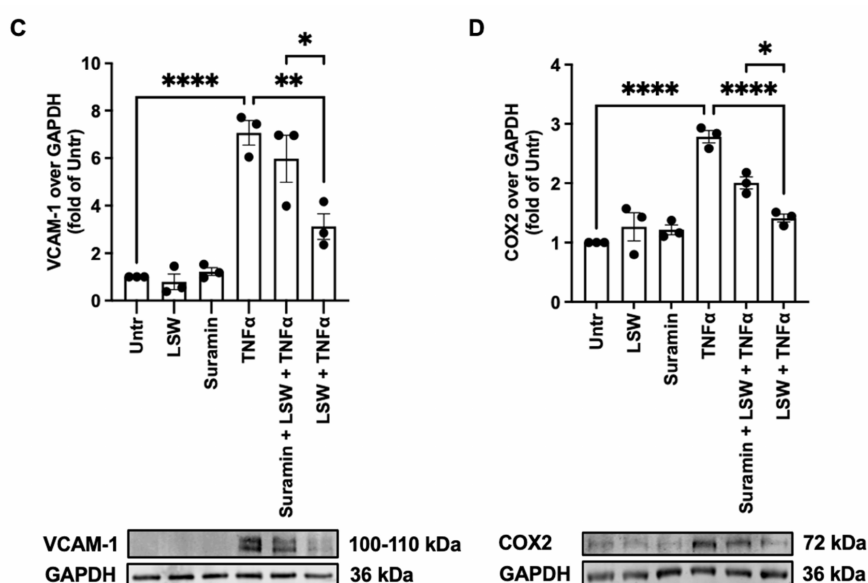
Figure 6. LSW attenuates TNF α -induced inflammation in EA.hy926 cells dependent on SIRT1. Panels ( A , B ) Effect of LSW treatment on SIRT1 expression. The cells were treated with LSW (50 µ M) for 18 h before TNF α (10 ng/mL) stimulation for 6 h, followed by detecting SIRT1 mRNA ( A ) or protein ( B ) expression. Panels ( C , D ) Involvement of SIRT1 in LSW’s anti-inflammatory effect. The cells were treated with SIRT1 antagonist (suramin) for 30 min and co-treated with LSW (50 µ M) for 18 h, before TNF α (10 ng/mL) stimulation for 6 h, followed by detecting the protein expression of VCAM-1 ( C ) and COX2 ( D ). Both mRNA and protein expression were normalized to GAPDH. Data were normalized to the untreated group (Untr). *, p < 0.05; **, p < 0.01; ****, p < 0.0001; ns, not